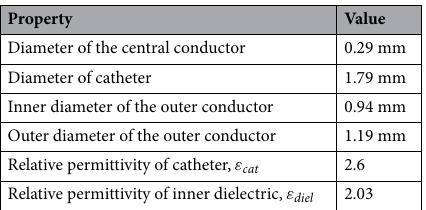
Table 3. Dimensional and electromagnetic properties of microwave antenna for Hepatocellular carcinoma treatment 23